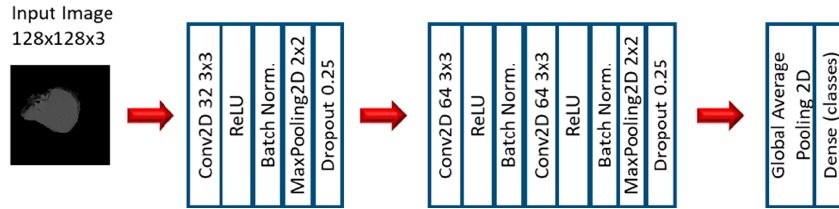
Figure 5. Architecture 6 of CNN base models.